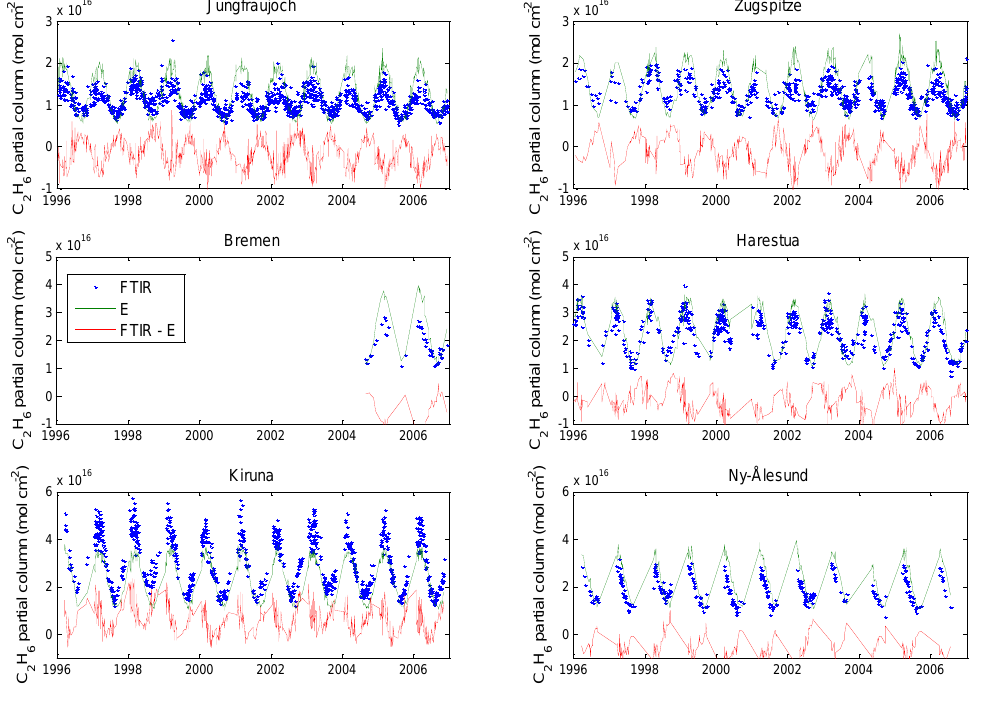
Figure 2. As in Figure 1 but for C